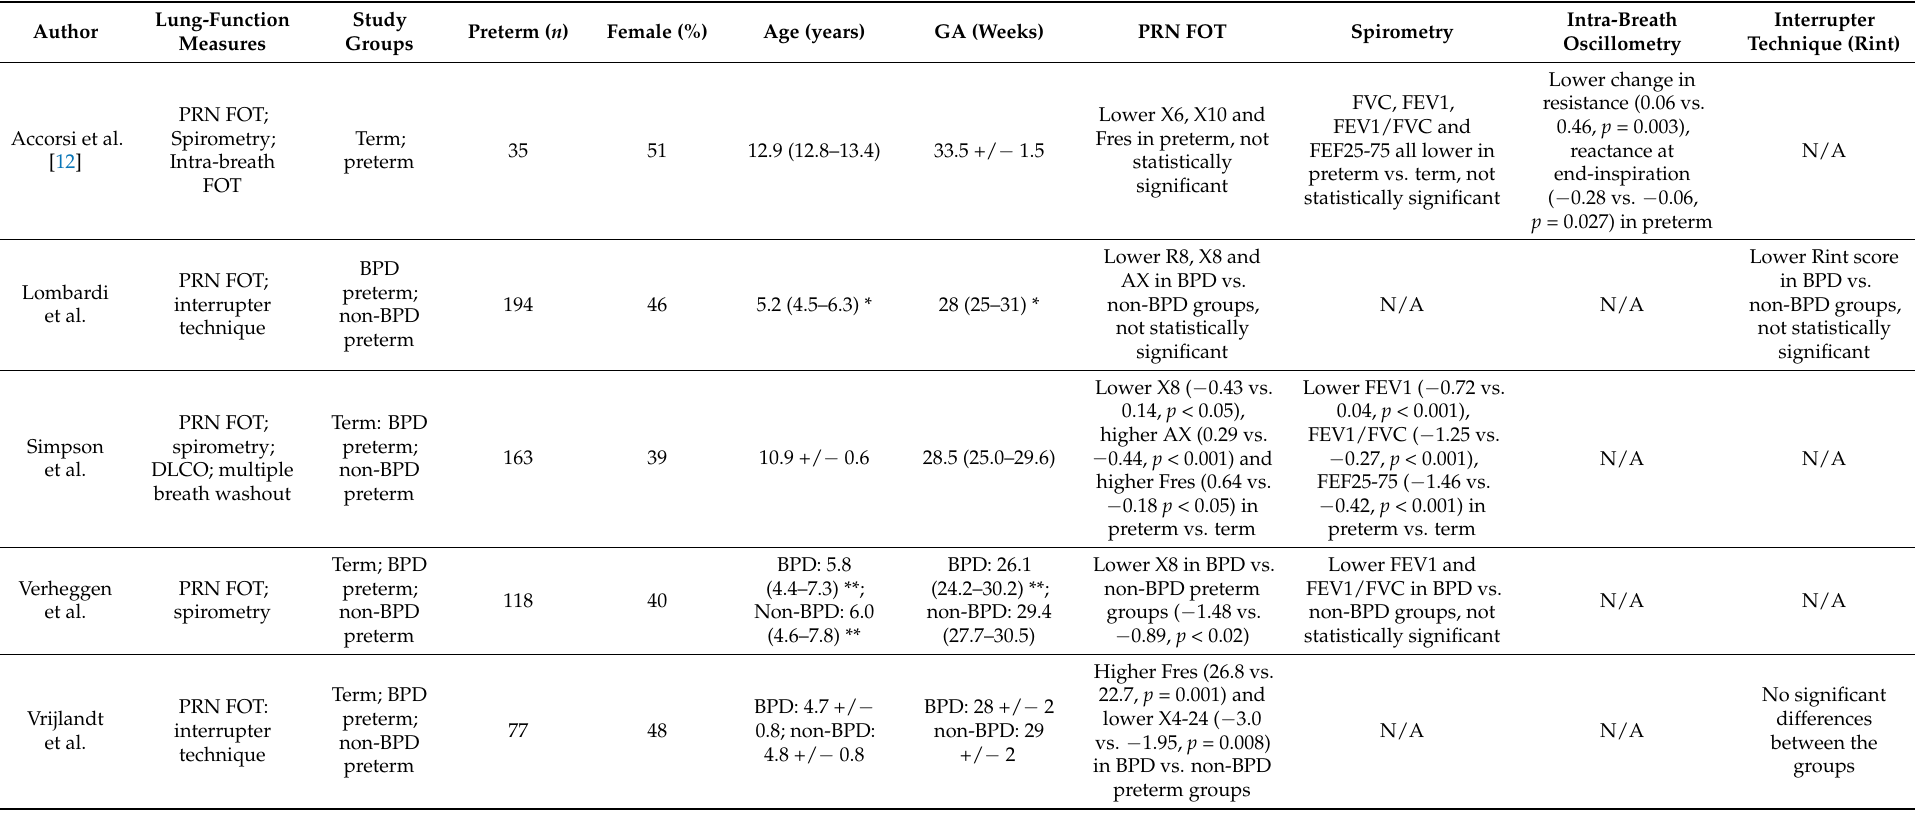
Table 1. Details of the studies included in the systematic